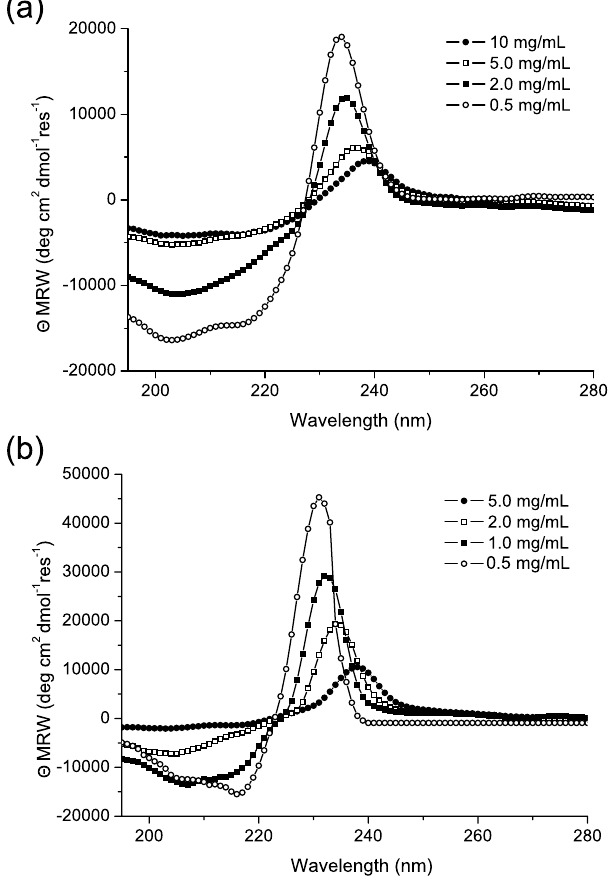
Figure 2. Selected Far-UV CD spectra of 2Nal 2 ( a ) and Gd-2Nal 2 ( b ) in a concentration range of 0.5–20.0 mg mL − 1 . Spectra are recorded between 280 and 195